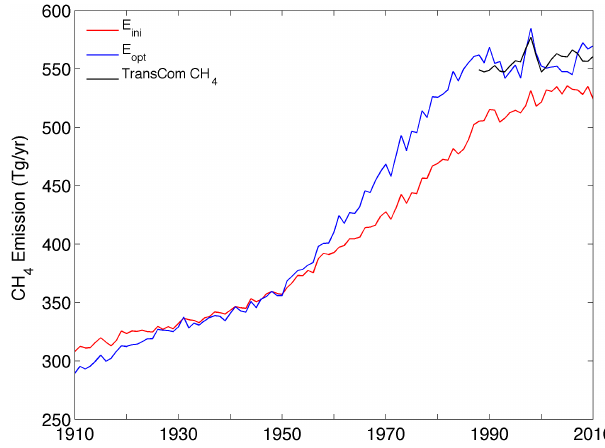
Figure 4. Time series of initial ( E ini ) and optimized ( E opt ) emis- sions. Emissions for a shorter period from the TransCom-CH 4 ex- periment (Patra et al., 2011) are also shown for a